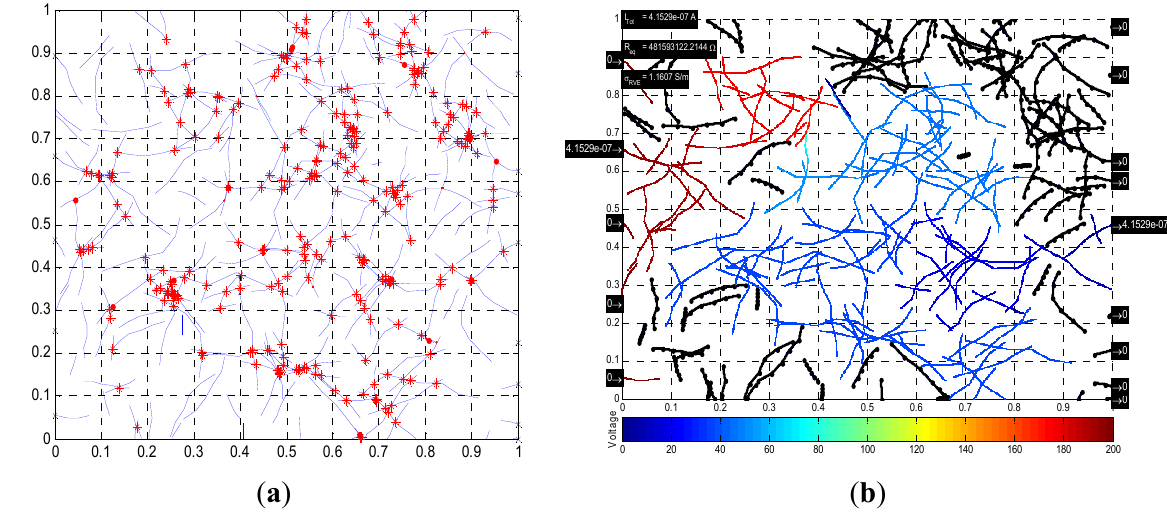
Figure 19. ( a ) Microstructure with length/diameter distributions, c = 0.015; and ( b ) corresponding nodal voltage diagram.